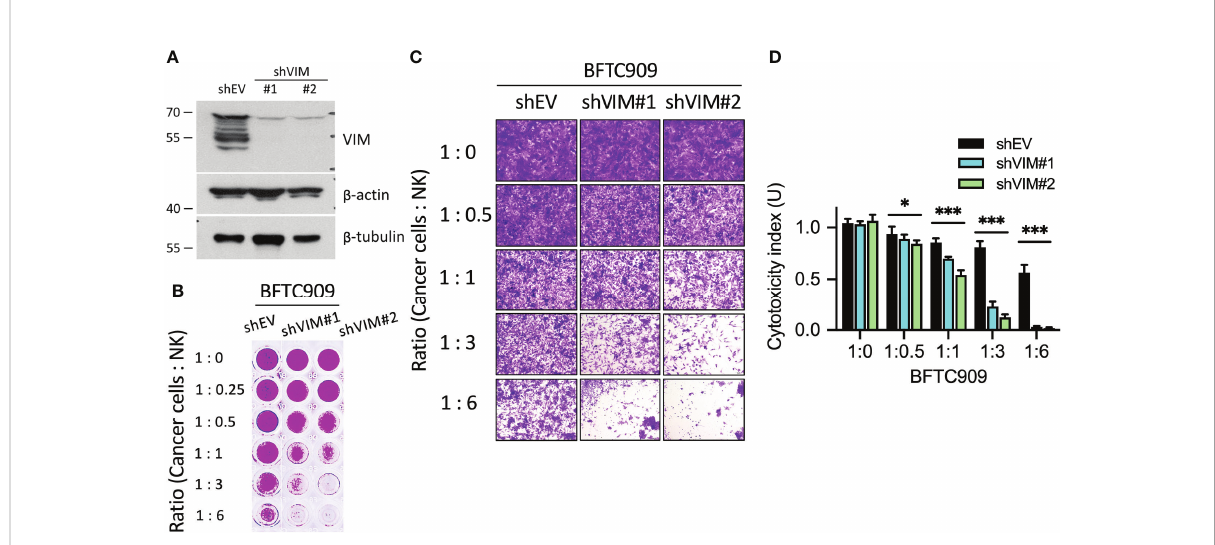
FIGURE 8 Silencing of vimentin enhanced NK cell-mediated cell death. (A) Silencing ef fi cacy of shVIM#1 and shVIM#2 by western blot. (B) Silencing of vimentin in urothelial cancer cells increased NK cytotoxicity. BFTC909 cells were silenced with shEV, shVIM#1 or shVIM#2 and stable cells were screened. The stable cells were seeded in the 96-well plate 24 h and then incubated with NK cells for 24 h. (C) BFTC909-shEV, shVIM#1 or shVIM#2 cells were co-cultured with NK cells for 24 h and stained with crystal violet. The stained cells were observed using a microscope. (D) The stained cells were counted and statistically analysis was performed using the Prism software. * P < 0.05; *** P < 0.001. Data are presented as means ± s.d. (two-way ANOVA with Tukey ’ s multiple comparisons test) and experiments were repeated three times (n =